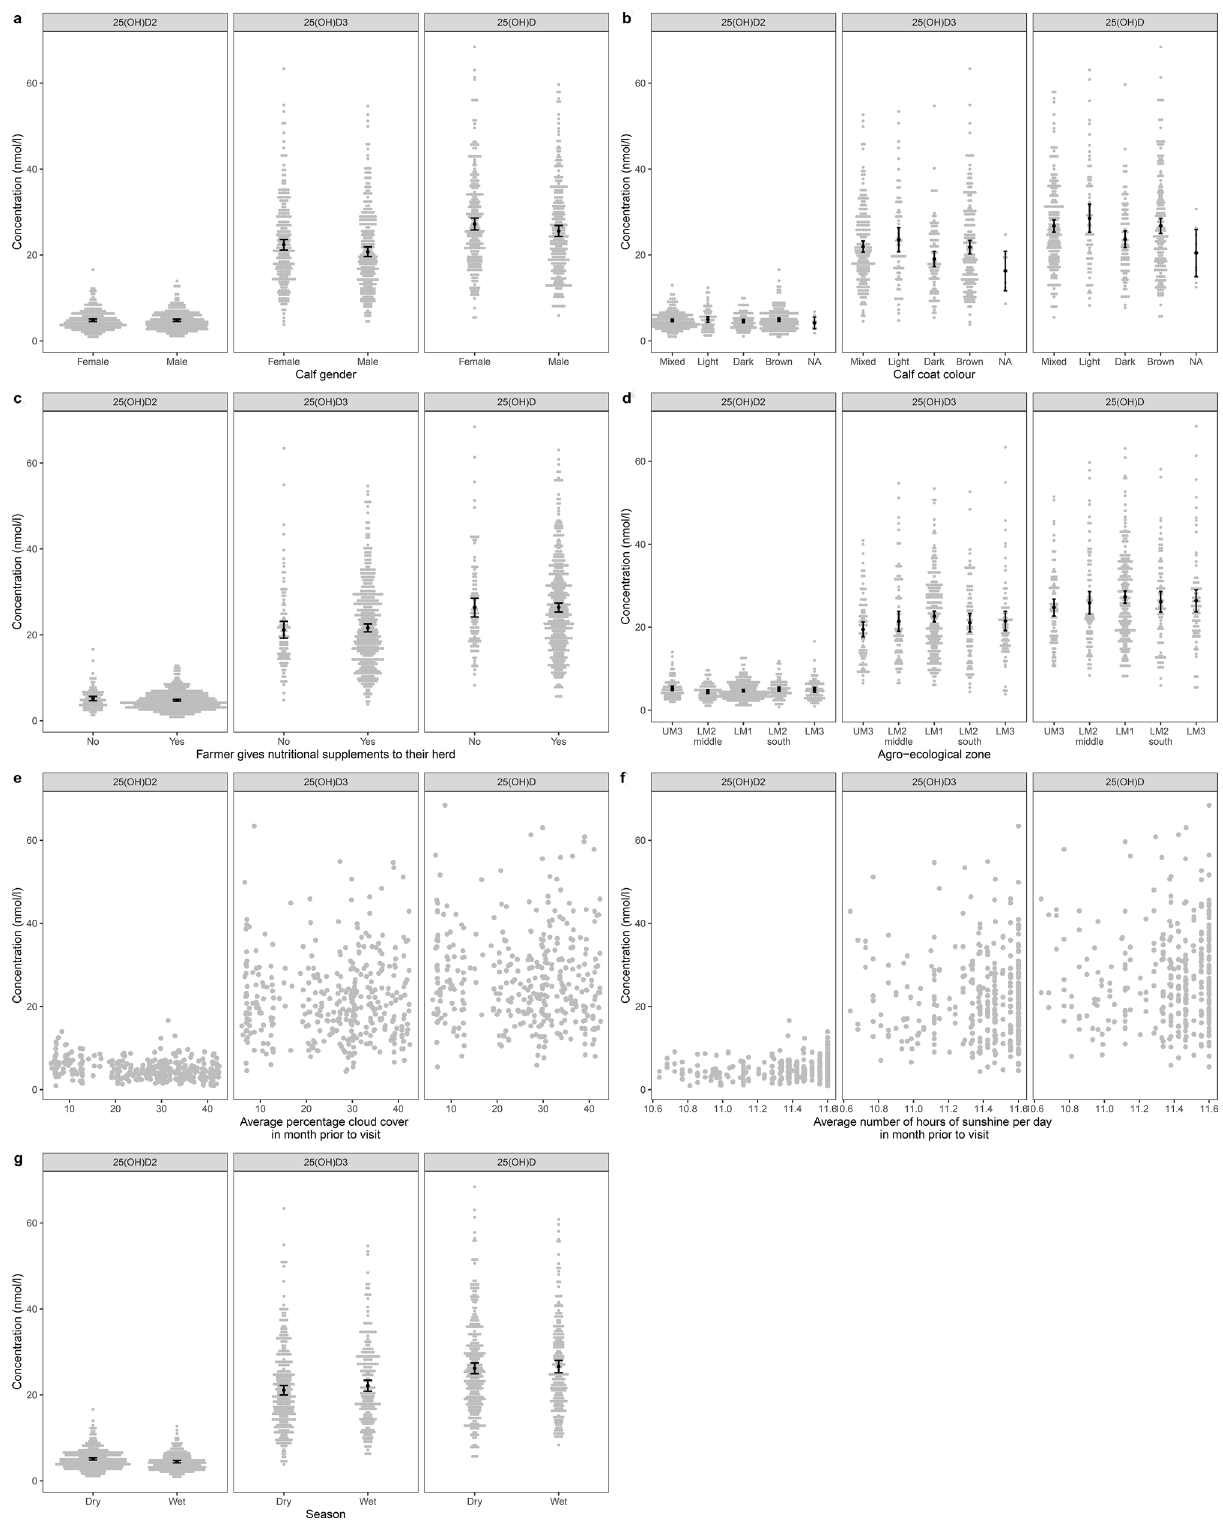
Figure 3. Graphs showing serum 25(OH)D concentration and calf and environmental level variables of interest. Black points represent the mean with 95% confidence interval. (a) Calf gender; (b) calf coat colour; (c) nutritional supplements; (d) agro-ecological zone; (e) average percentage cloud cover in month prior to visit; (f) average number of hours of sunshine per day in month prior to visit; (g) wet or dry